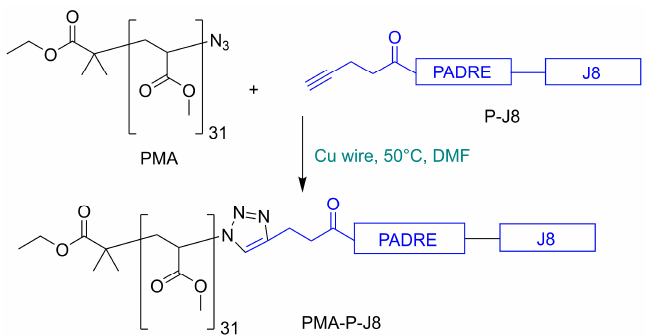
Figure 1. Schematic illustration of the synthesis of the vaccine candidate containing J8 B-cell epitope, PADRE universal T-helper (AKFVAAWTLKAAA) epitope, and poly (methyl acrylate) (PMA), PMA- P-J8.